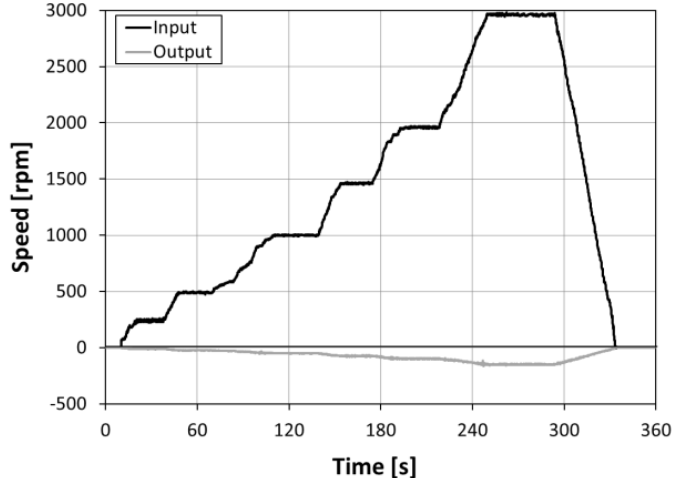
Figure 11. Input and output speed